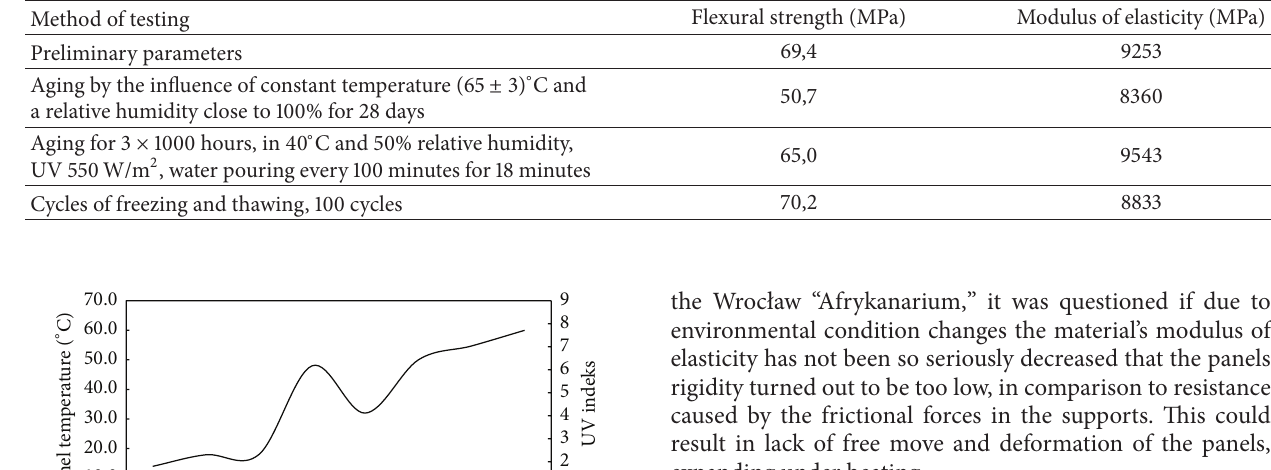
Table 2: The average strength characteristics resulting from aging tests of Corian (PMMA/ATH) panels [4].